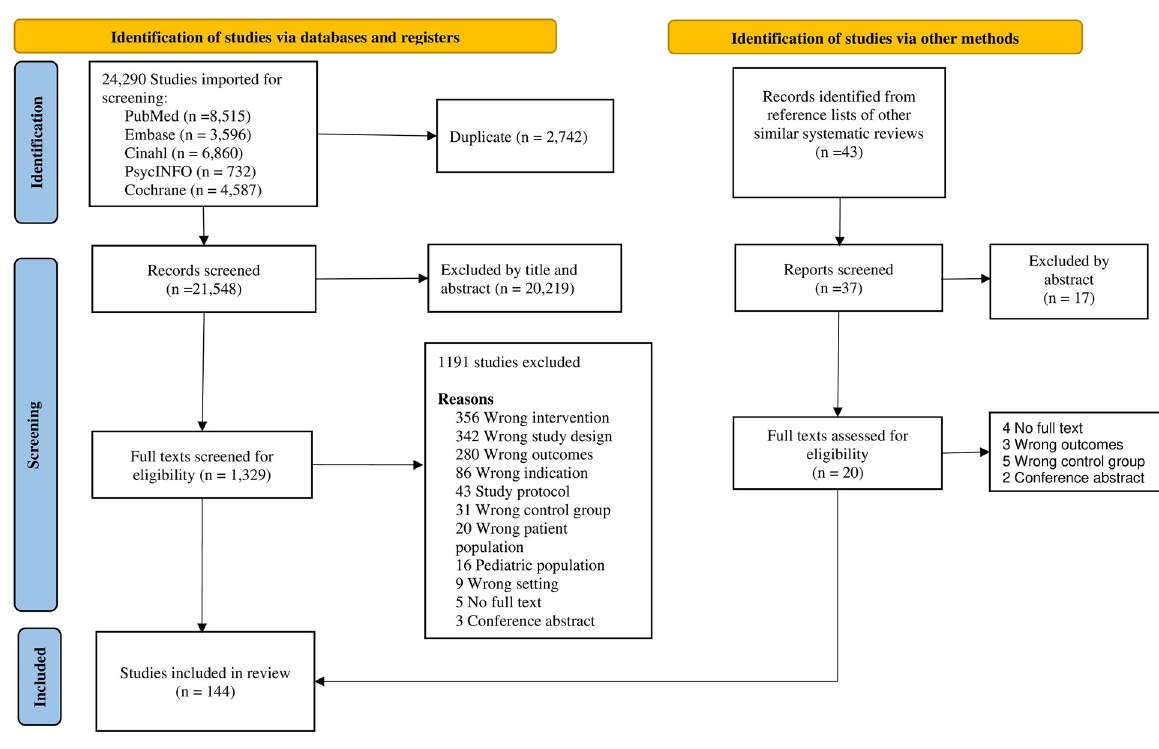
Fig 1. Adapted PRISMA